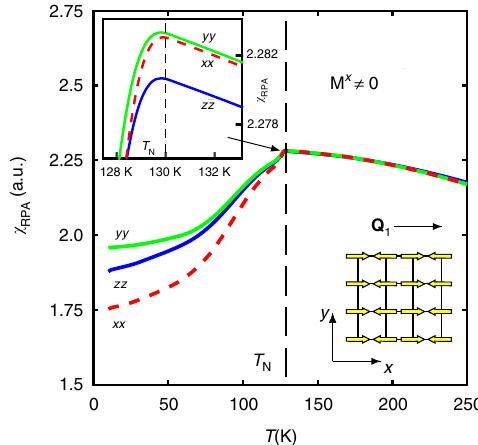
Fig. 4 Theoretical calculations. Magnetic susceptibility calculated in the stripe AF phase using an itinerant multi-orbital model (coordinate basis is transformed as a → x , b → y , c → z in comparison with experimental data). The magnetic moments are arranged parallel to the AF wave vector Q 1 so that M x ≠ 0, M y , z = 0 resulting in χ yy > χ xx in agreement with experiment. The inset shows an enlarged view near the transition, where an extremely weak splitting ( ≪ 1%) between χ xx and χ yy occurs in the paramagnetic state due to the fi nite orbital ordering ( Δ oo = − 25 Figure 3 highlights the surprisingly different behavior of the susceptibility anisotropy, χ b − χ a , and the resistivity anisotropy, − ρ ρ − ρ ρ b a . Whereas b a is peaked close to and extends considerably above T N , χ b − χ a only starts to develop slightly above T N and then increases to the lowest temperatures. Thus, the resistivity anisotropy and the susceptibility anisotropy do not scale linearly with each other above the transition, in contrary to the expectation of the spin-nematic scenario 10, 11 .